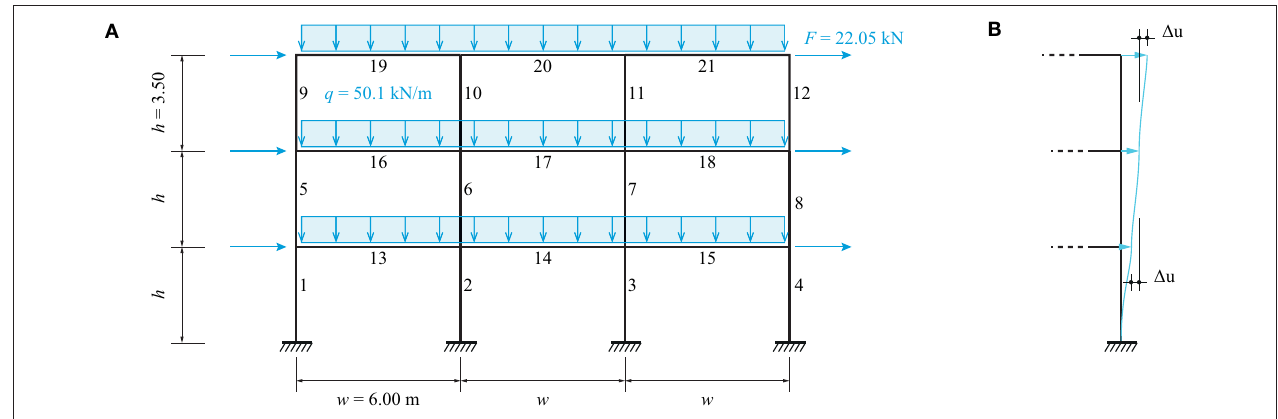
FIGURE 6 | Three-bay-three-story frame: (A) dimensions and loading, (B) inter-story drift limit.